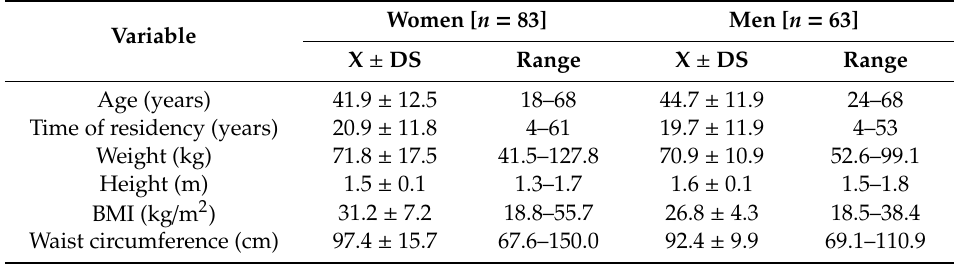
Table 1. General characteristics of migrant agricultural workers in Miguel Aleman and Pesqueira, Sonora at northern Mexico.